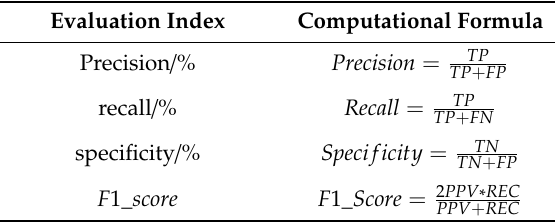
Table 2. Evaluation index formulas.